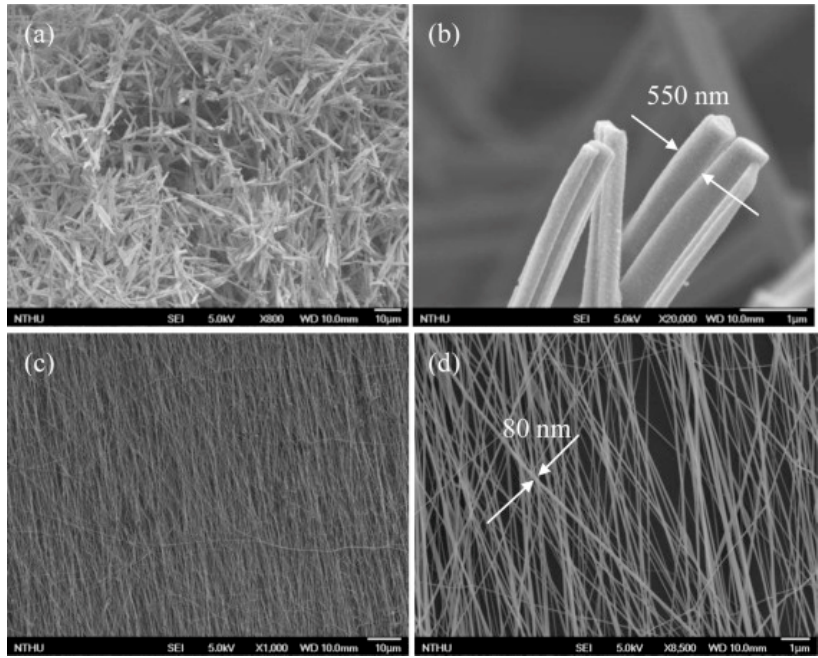
Figure 25. Scanning electron microscopy (SEM) images of TiO 2 nanowires made from hydrolysis ( a , b ) and from electrospinning ( c , d ). Reproduced with permission from [60]. and from electrospinning ( c , d ). Reproduced with permission from